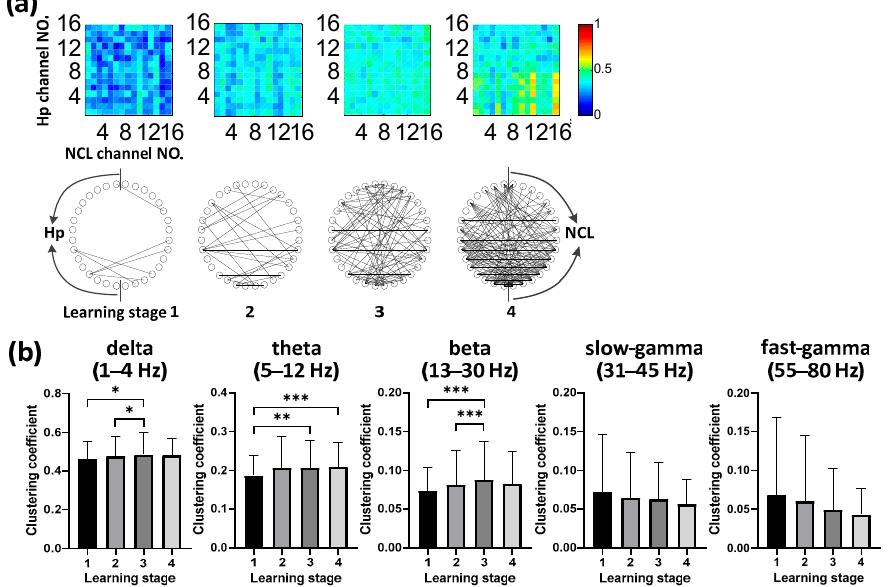
Figure 5. Synchronous activity between Hp and NCL during route formation in spatial learning. ( a ) Examples (from P100) of heatmaps of the Hp-NCL LFP coherence coefficient matrices and binarized functional networks for different learning stages in the theta band. ( b ) Clustering coefficient of functional Hp-NCL network (from all pigeons) for different bands across learning stages (* p < 0.05, ** p < 0.01, *** p < 0.001; Friedman ANOVA; n = 6 animals, 16 sessions). Data are presented as mean ± std.